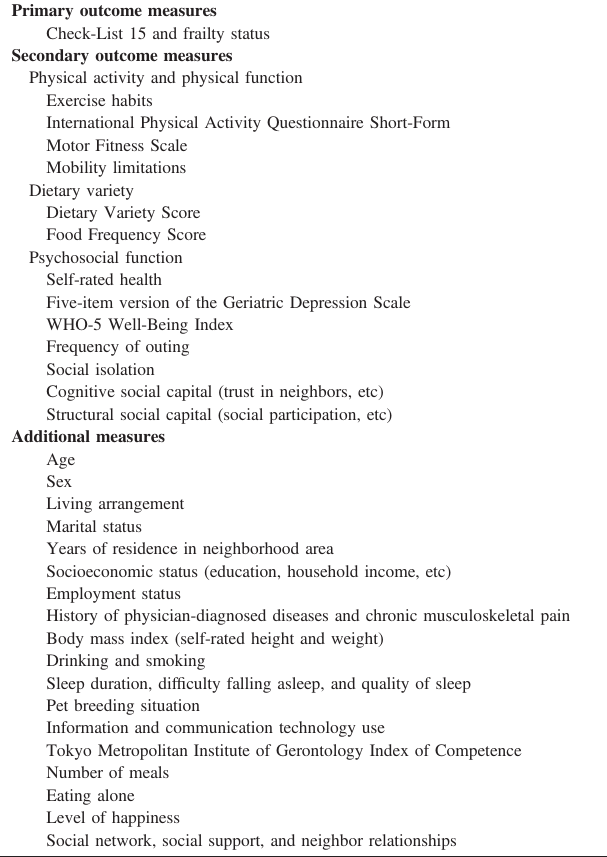
Table 1. Summary of items surveyed in the Ota Genki Senior Project at baseline,